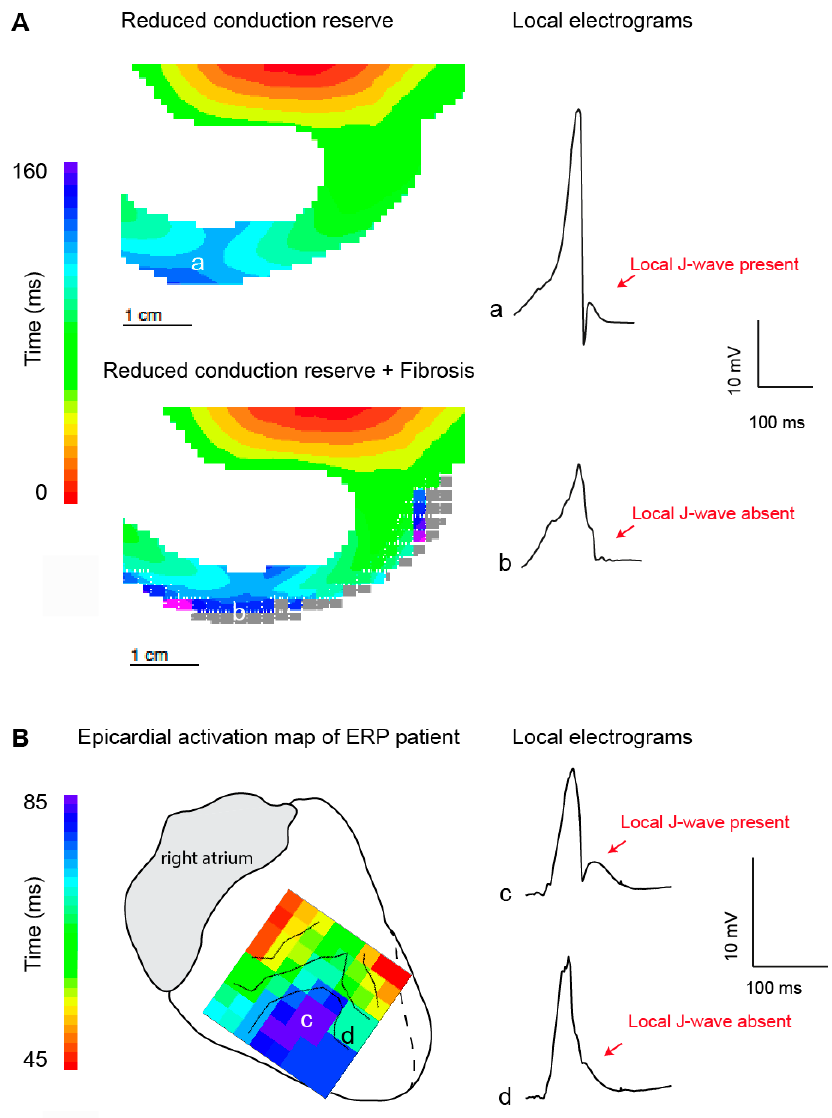
Figure 2. Local J ‐ wave and excitation failure in relation to the early repolarization syndrome. ( A ). Simulated activation maps and extracellular potentials during sodium channel reduction (30%) in the absence (upper) and presence (lower) of structural abnormalities. Propagation and extracellular potential were simulated using a similar approach as published previously [12]. In brief, propagating action potentials (AP) were simulated with a monodomain reaction ‐ diffusion equation, using software that has been described previously [40]. Ionic currents were computed with the Ten Tusscher ‐ Noble ‐ Noble ‐ Panfilov model for the human ventricular myocyte [41], which distinguishes subendocardial, mid ‐ myocardial, and subepicardial cell types. Computation of extracellular potentials (electrograms) from the simulated membrane potentials was based on the bidomain model for cardiac tissue [42]. Delayed activation in location a resulted in a pronounced J ‐ wave in the corresponding local electrograms. In the presence of structural abnormalities excitation failure occurred and the local J ‐ wave disappeared. Panel ( B ) shows the epicardial activation pattern at the right inferior wall measured during open chest mapping [16]. The delayed activated myocardium (in blue) showed unipolar electrograms with (c) and without (d) a local J ‐ wave. We speculate that excitation failure occurred at location d. ERP, early repolarization pattern.